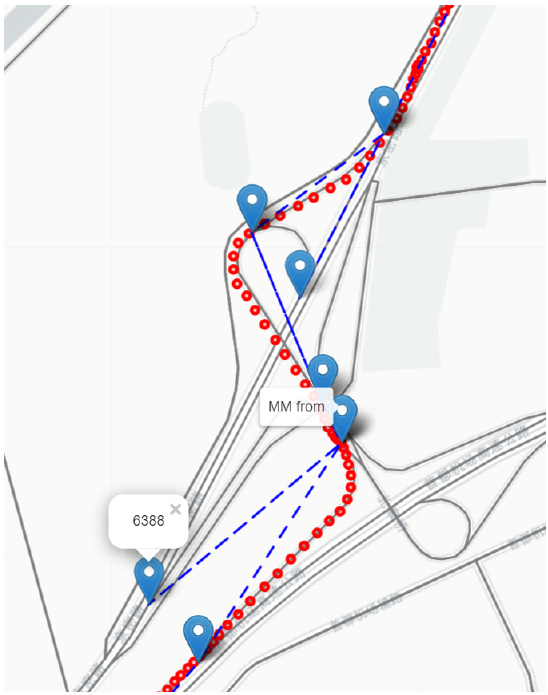
Figure 8. A screenshot of the visual inspection